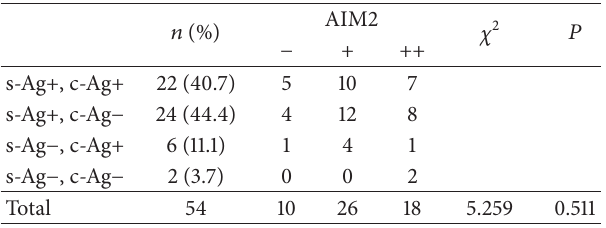
Table 3: Expression of AIM2 was negatively correlated with gender, age, and serum e-Ag in HBV-GN.